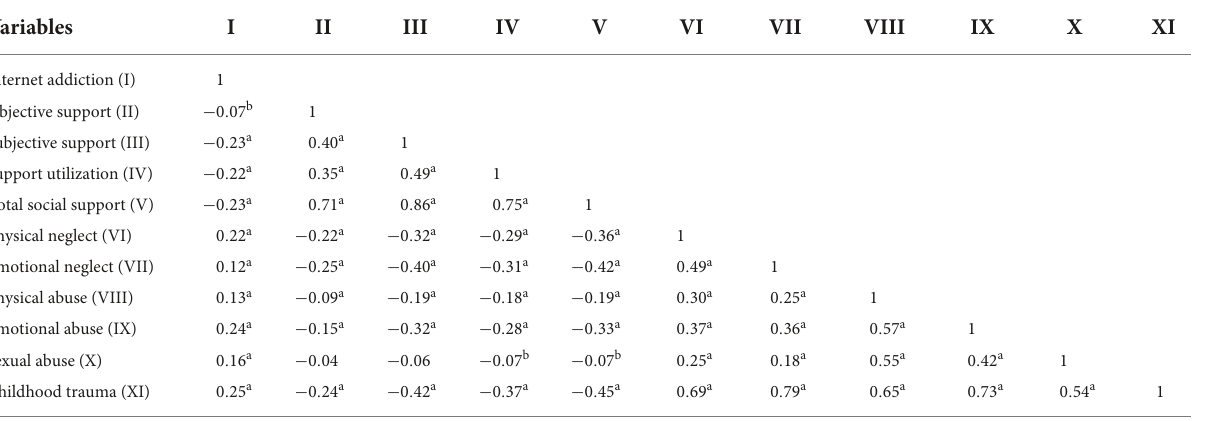
TABLE 3 Correlation coefficient between social support, childhood trauma, and Internet addiction.